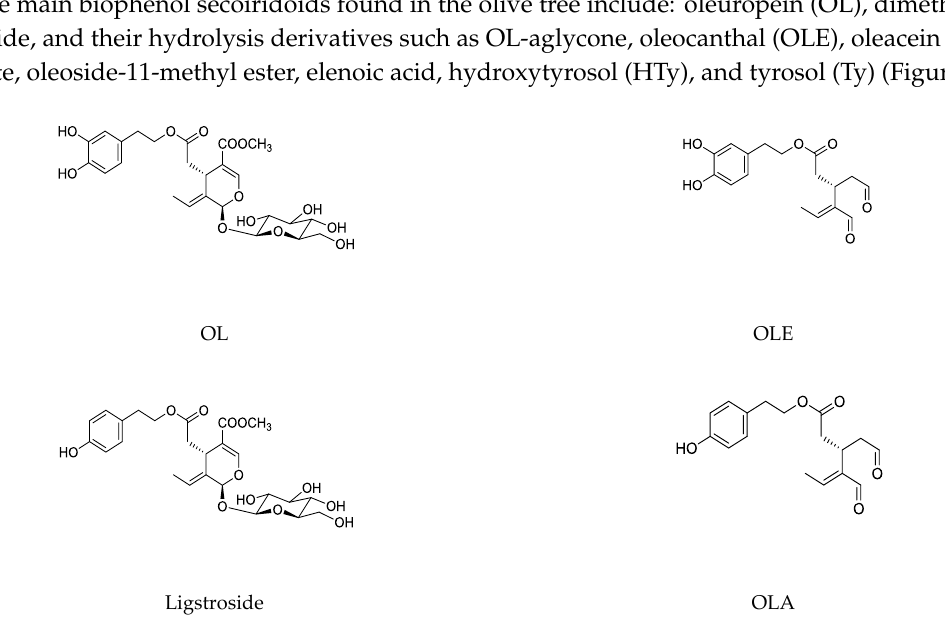
Figure 1. Chemical structures of secoiridoids most abundant in olive trees. OL: oleuropein, OLA: oleacein, OLE: oleocanthal.